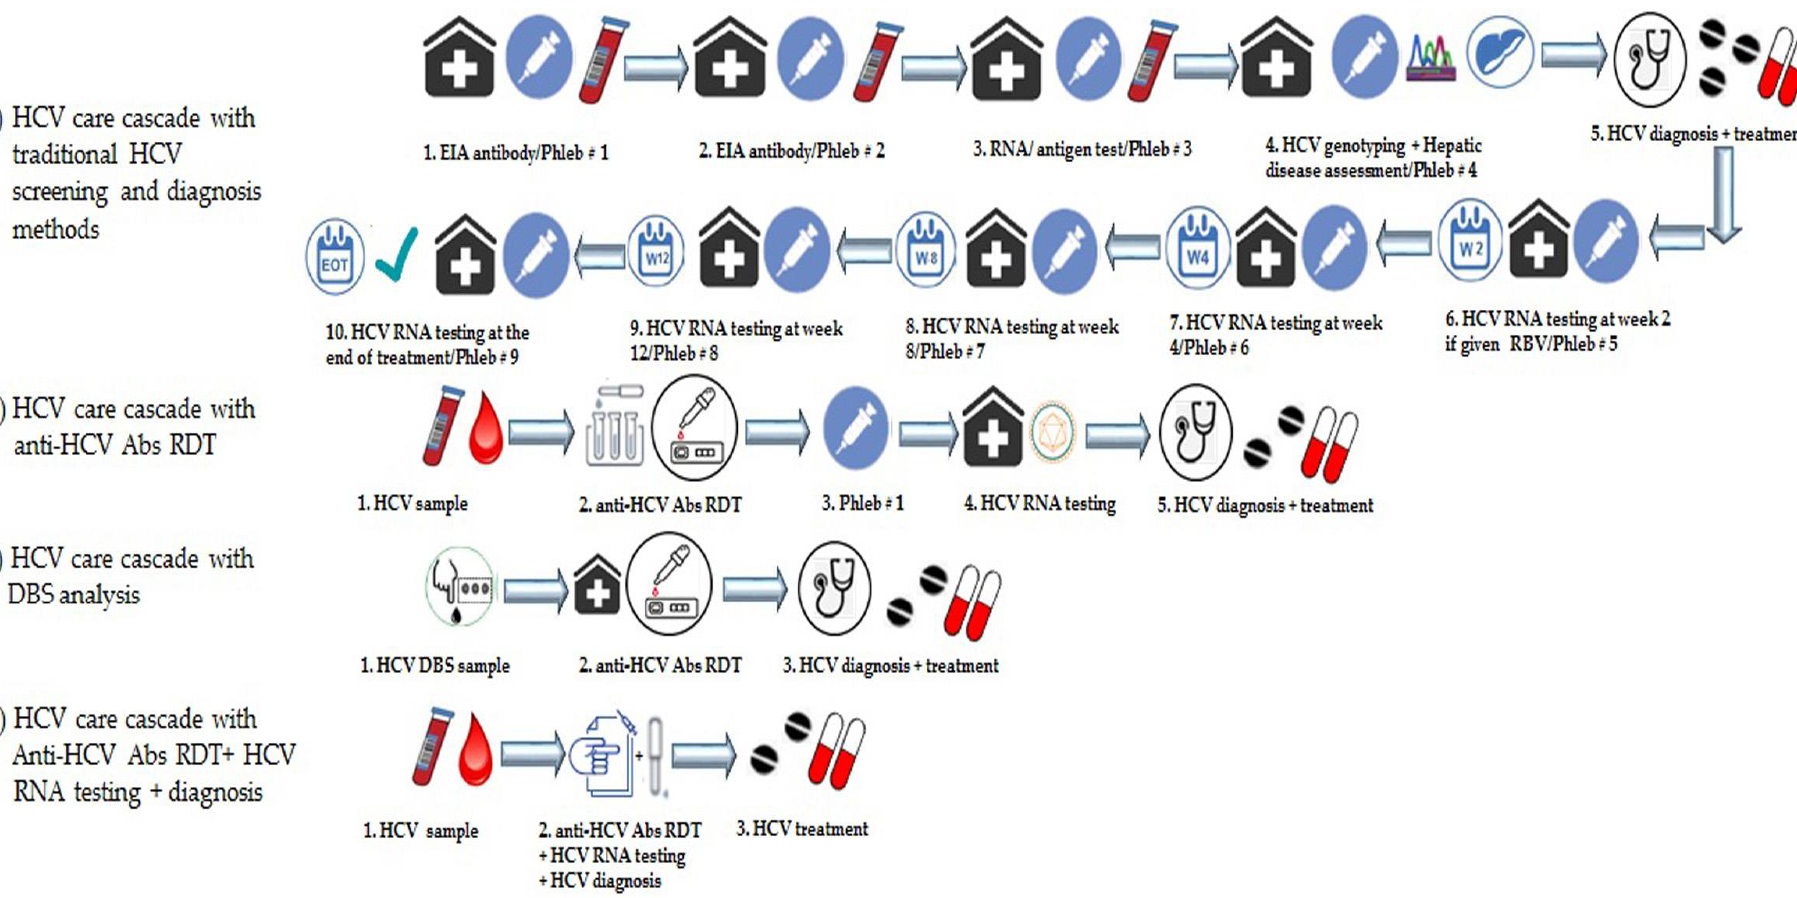
Figure 2. A schematic illustration deciphering the importance of simplified HCV diagnosis solutions to minimizing steps to infection diagnosis and pursuit a single visit diagnosis than the traditional complicated diagnostic pathways in HCV care cascade. ( a ) elaborates the traditional HCV screening and diagnostic procedures in a care cascade which requires 10 single visits, 9 phlebotomies, HCV genotyping assessment, and liver disease staging for disease assessment from HCV screening to infection cure [48]. ( b ) demonstrates the anti-HCV antibodies (Abs) rapid diagnostic tests (RDTs) from HCV screening to treatment which requires four single visits from screening to treatment, one phlebotomy for active infection confirmation, and skipping HCV genotype assessment provided that the patient is prescribed to pan-genotypic DAAs regimens for treatment; however, liver disease staging for disease assessment may require for determining cirrhosis status of the patient (i.e., present or absent; compensated or decompensated cirrhosis), for treatment initiation, treatment type, and length of HCV